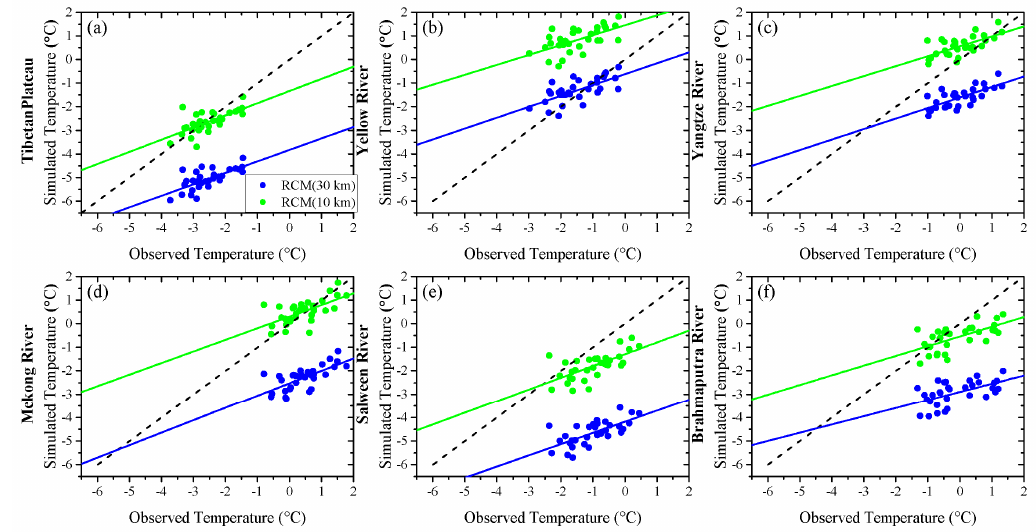
Figure 10. Scatterplots of observation and simulated annual mean temperature over the whole TP ( a ) and five river basins (from b to f ) and during the period 1980 − 2010. The diagonal black dashed line across the plot shows the perfect agreement.